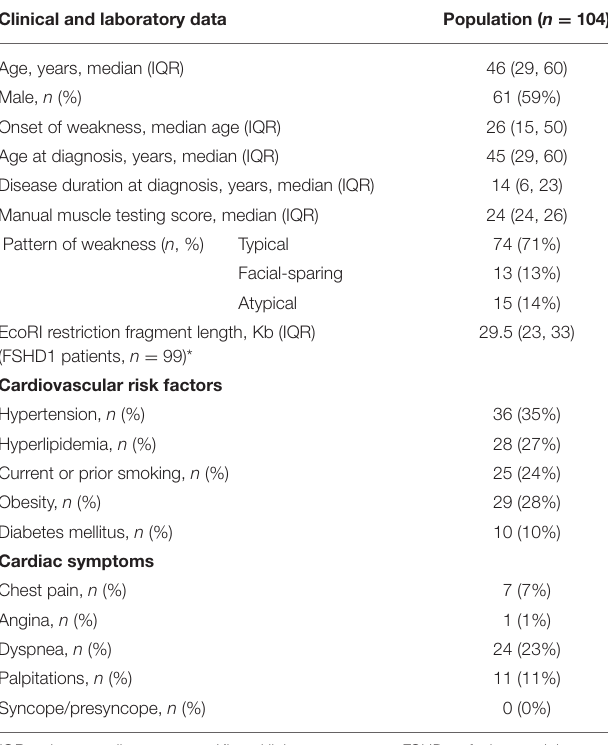
TABLE 1 | Clinical data, genetic findings, and cardiovascular risk factors in facioscapulohumeral muscular dystrophy (FSHD) type 1 and 2 patients. Clinical and laboratory